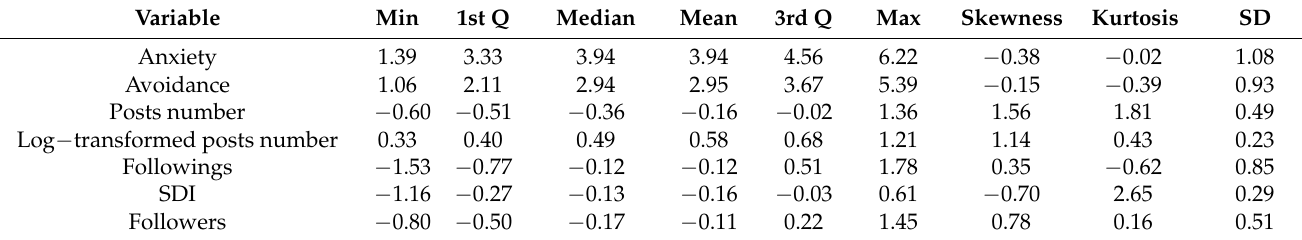
Table 1. Summary of the descriptive statistics for each continuous variable. The distributions of ECR-R (Anxiety and Avoidance) and Instagram metrics (number of posts, followings, Social Desirability Index and followers) are described in terms of Minimum (Min), first Quartile (1st Q), Median, Mean, third Quartile (3rd Q), Maximum (Max), Skewness, Kurtosis and Standard Deviation (SD). Log-transformed number of posts shows increased values compared to the original sampling of the same